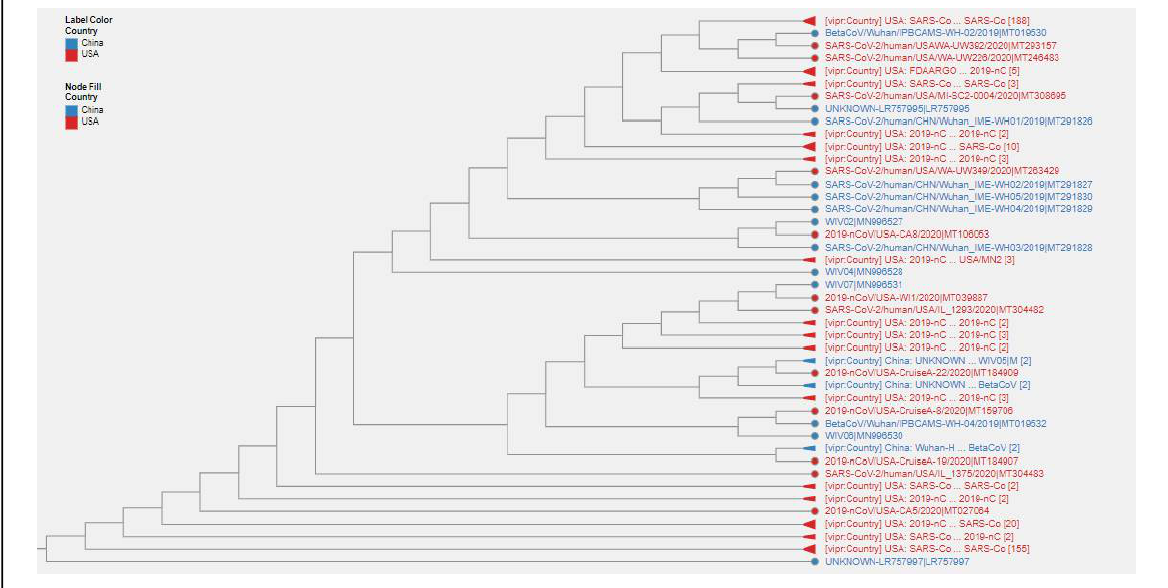
Figure 1: A Phylogenetic tree showing the COVID-19 strains from USA (in red) and their relationship to the sequences from China (in